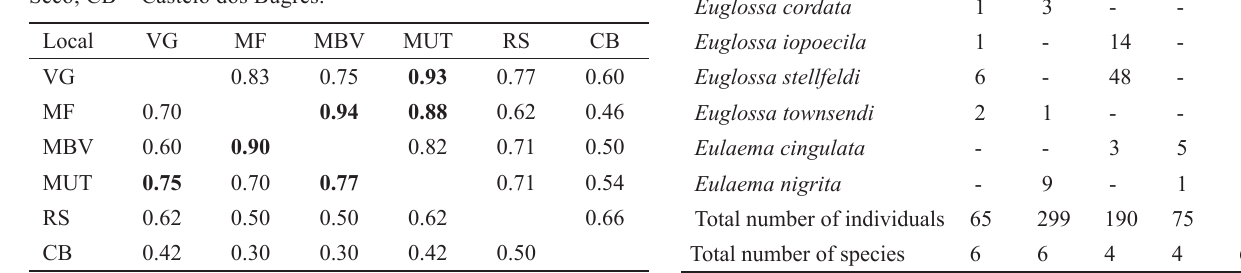
Table 2 . Indexes applied to all possible combinatory pairs for the studied location. Upper diagonal, Sorensen’s index (in bold, the most similar locations); Lower diagonal, Renkonen’s index (in bold, the most similar locations). Subtitles: VG = Vila da Gloria; MF = Morro do Finder; MBV = Morro do Boa Vista; RS = Rio Seco; CB = Castelo dos Bugres.